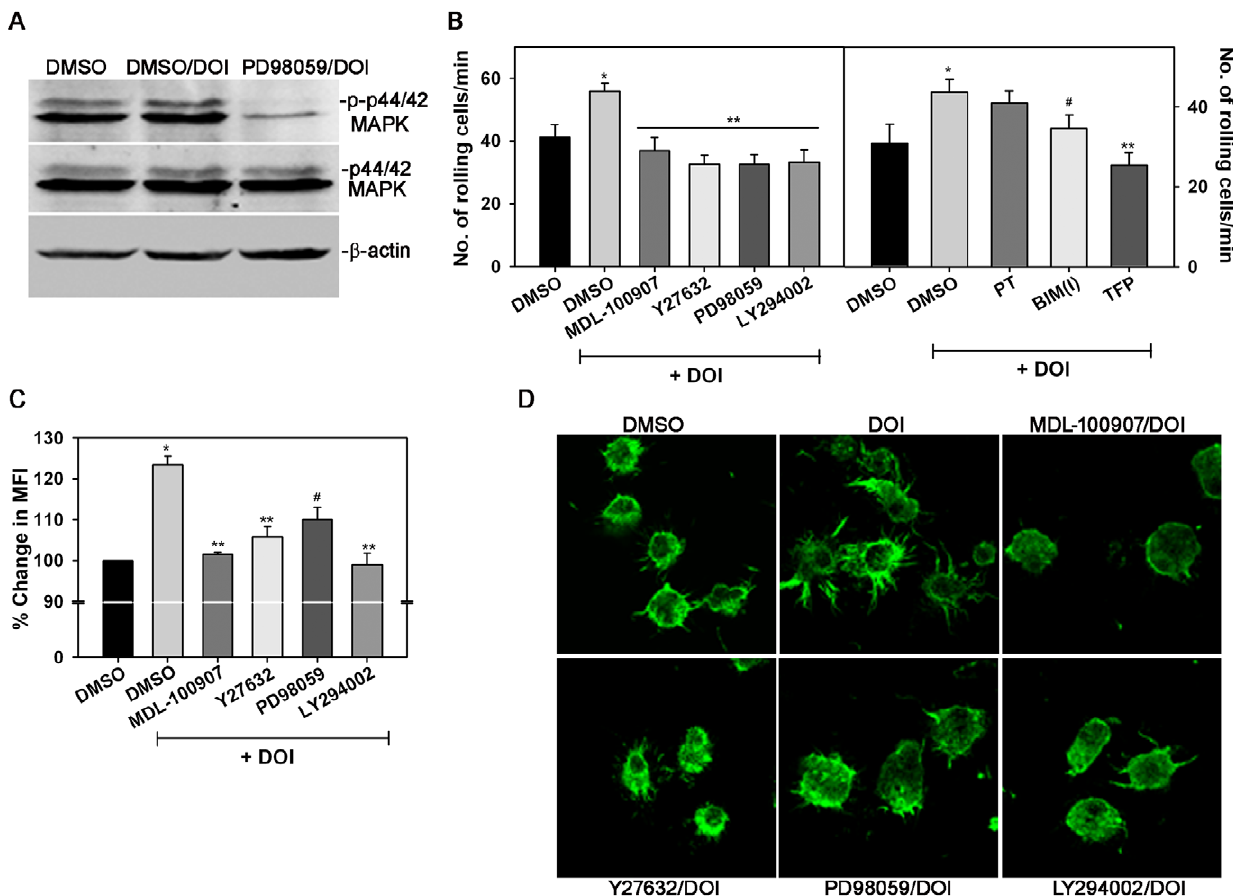
Figure 3. DOI-induced rolling of AML14.3D10 cells involves activation of ROCK, MAPK PI3K, PKC and calmodulin. ( A ) Phosphorylation of p-44/42 MAPK in cells exposed to DOI after pre-treatment with PD98059 (10 m M, MAPK inhibitor) or DMSO (vehicle for inhibitor) for 5 min. Cell lysates were analyzed by Western blot analysis. ( B ) DOI-induced rolling of AML14.3D10 cells on rh VCAM-1-coated cover-slips under conditions of flow in vitro after treatment with MDL-100907 (5-HT2A antagonist), Y27632 (ROCK inhibitor), PD98059, LY294002 (PI3K inhibitor) (left panel) or PT (G a